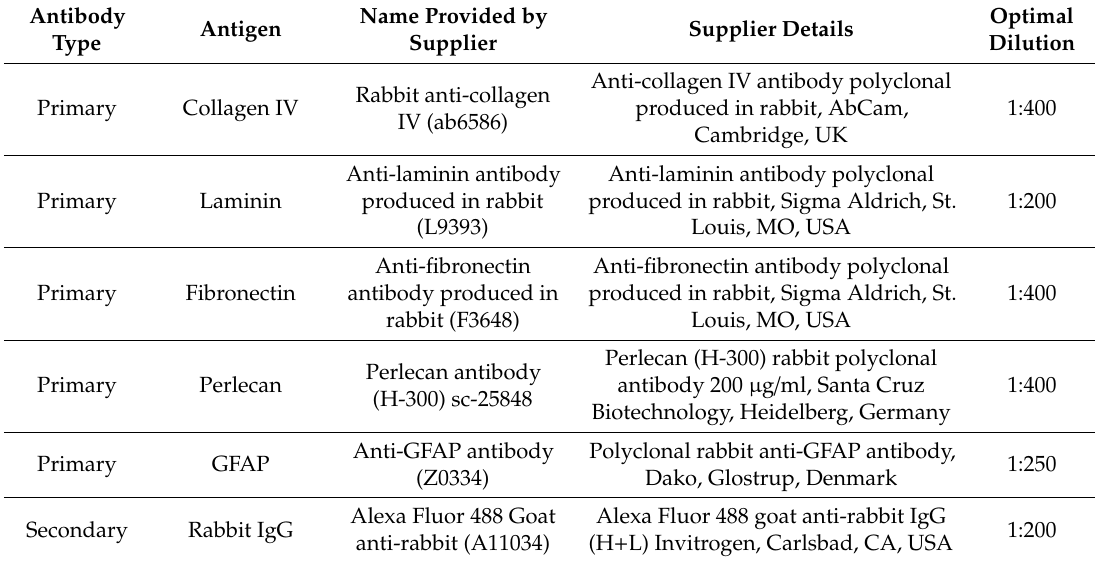
Table 1. Details of primary antibodies used in the